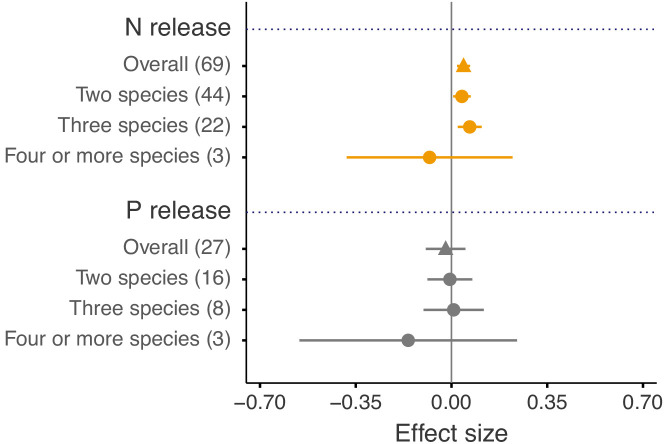
Overall average of N and P release and for each species richness level separately.Overall average of N and P release (triangles) and for each species richness level separately (circles). Effect sizes were calculated as the log response ratio between observed and expected values for each response variable and 95% bootstrap confidence intervals (CI) are shown. When there were several harvests through time, only the data from the final harvest were used for the calculation of effect sizes. The solid vertical black line indicates no effects (mean effect size = 0, observed values = expected values). Mean effect size >0 indicates synergistic effects (observed values > expected values), while mean effect size <0 indicates antagonistic effects (observed values < expected values). The non-additive effects (synergistic or antagonistic) are significant at α = 0.05 if the CI of the effect size does not overlap 0, while the effects are additive when there is overlap. The values in parentheses denote the number of observations.